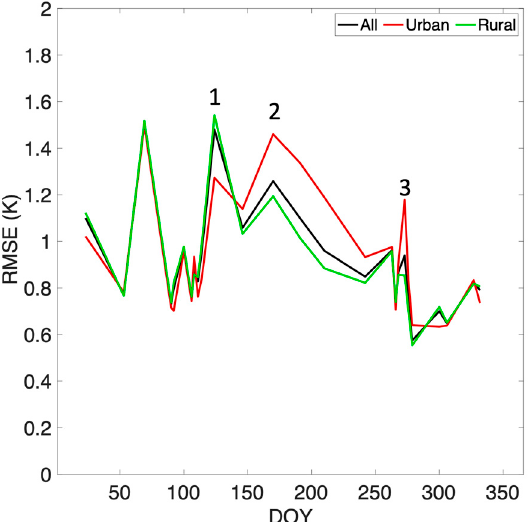
Figure 12. RMSE of the sharpened LST at the 100-m resolution for the entire scene (black line), urban areas (red line), and rural areas (green line). Three error peaks are marked by numbers.